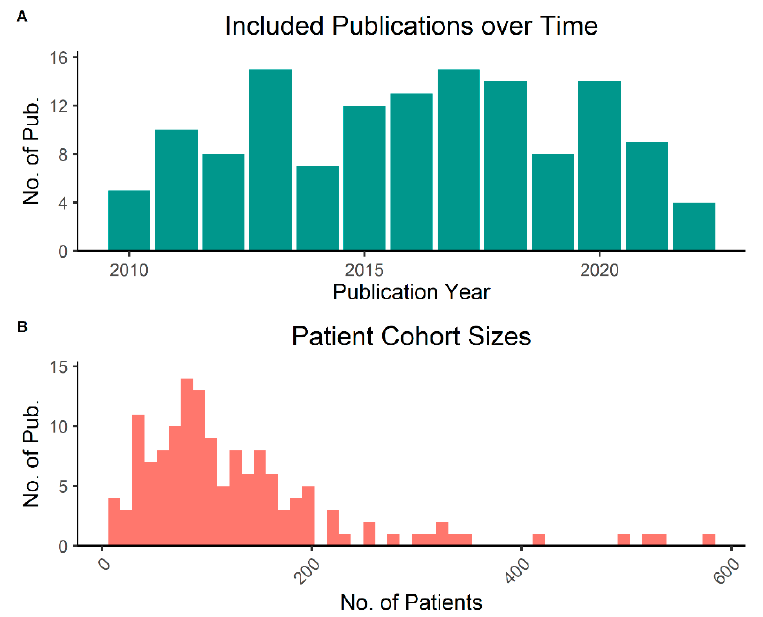
Figure 2. Number of included publications over the pre-defined time period ( A ). Histogram of the reported patient numbers that were included per study ( B ).